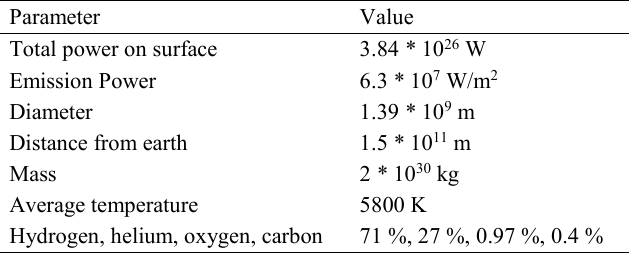
Table 1. Main specifications of the sun